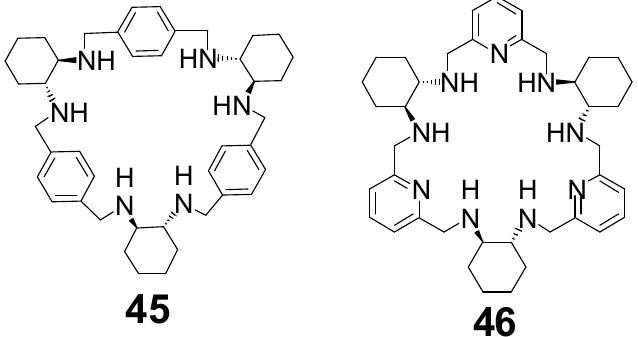
Figure 17. [3 + 3] amine macrocycles.